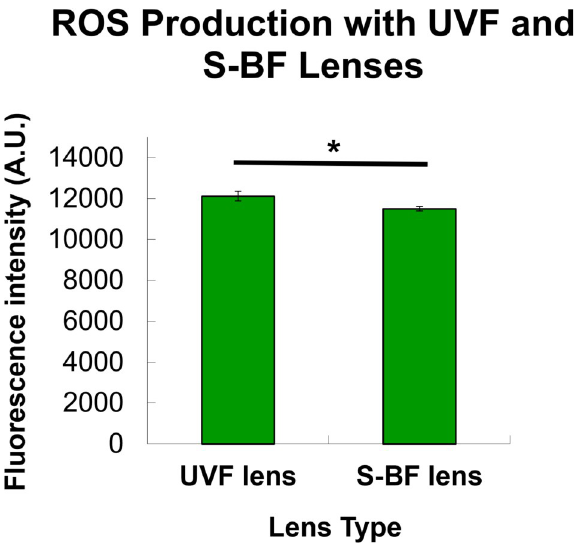
Fig 8. The level of Reactive Oxygen Species (ROS) under Selective Blue-Filtering (S-BF) and UV-Filtering (UVF) lenses. Under blue LED, RPE cells with the selective blue-filtering (S-BF) lens showed a lower level of ROS compared to the UV-filtering (UVF) lens (p = 0.038), indicating less oxidative stress was present when the S-BF lens was in place. (n = 3, t-test, � p < 0.05) The values are expressed as Mean ± SEM.